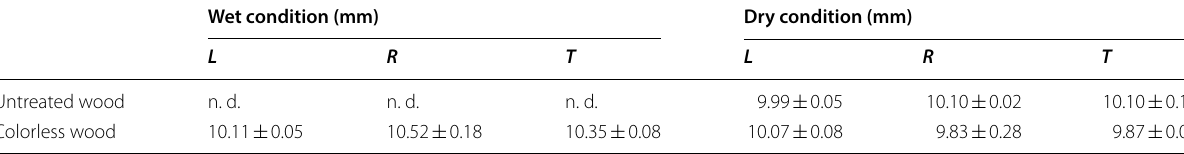
The value on size durability shows the average and standard deviation calculated from 3 samples